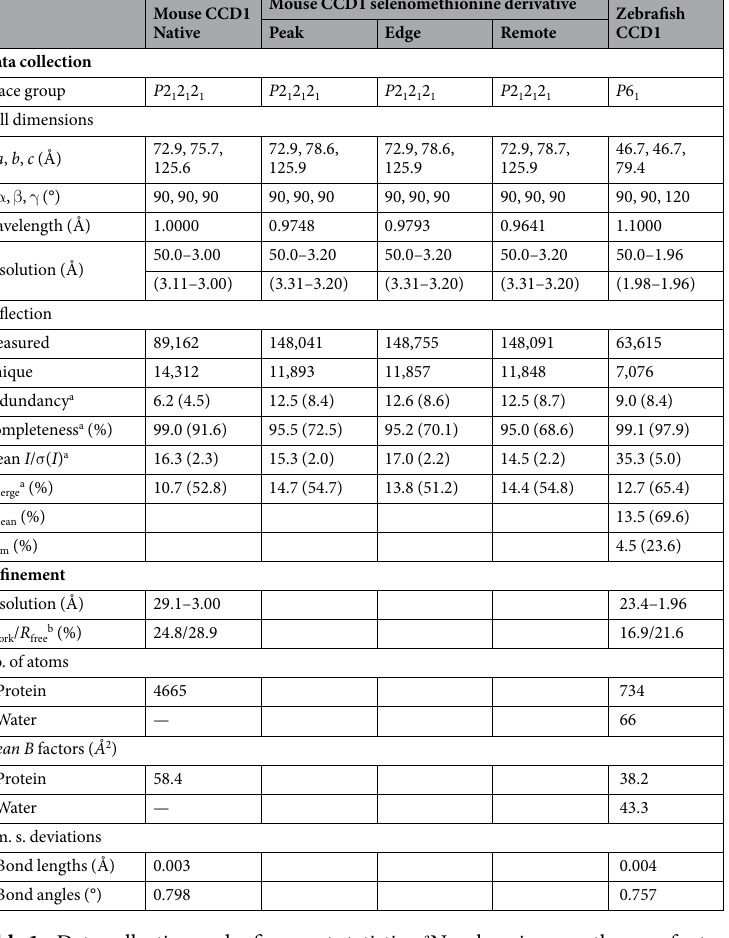
Table 1. Data collection and refinement statistics. a Numbers in parentheses refer to statistics for the